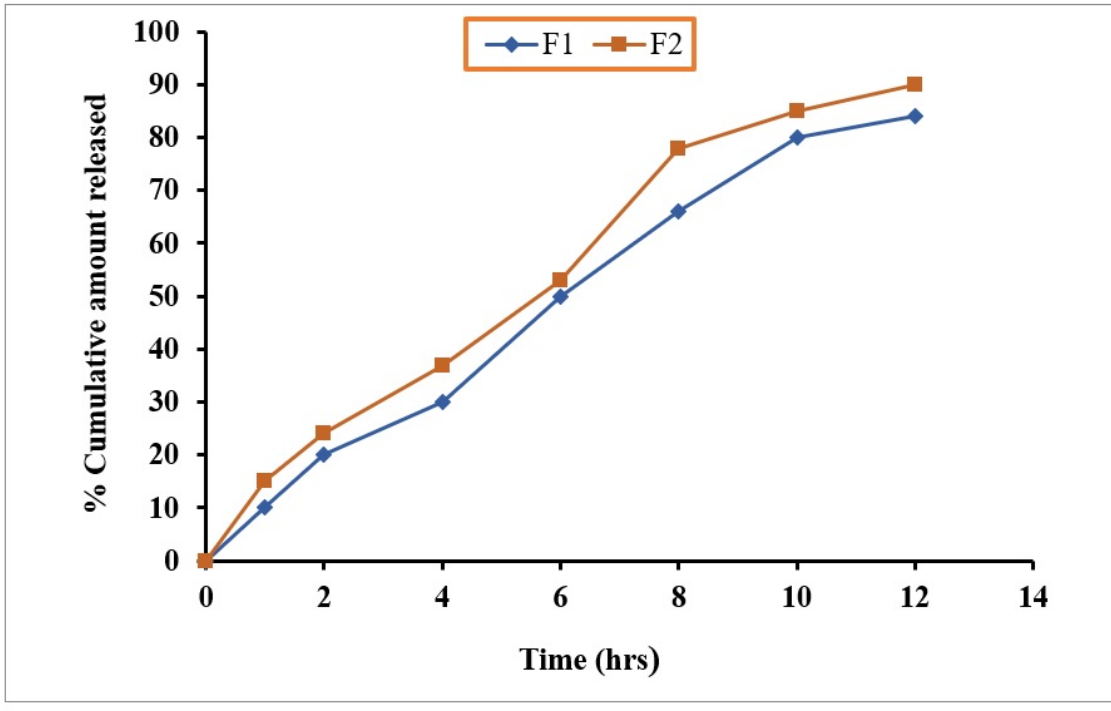
Figure 5. In vitro drug release of low dose (F1) and high dose (F2) of CuSQ hydrogel.